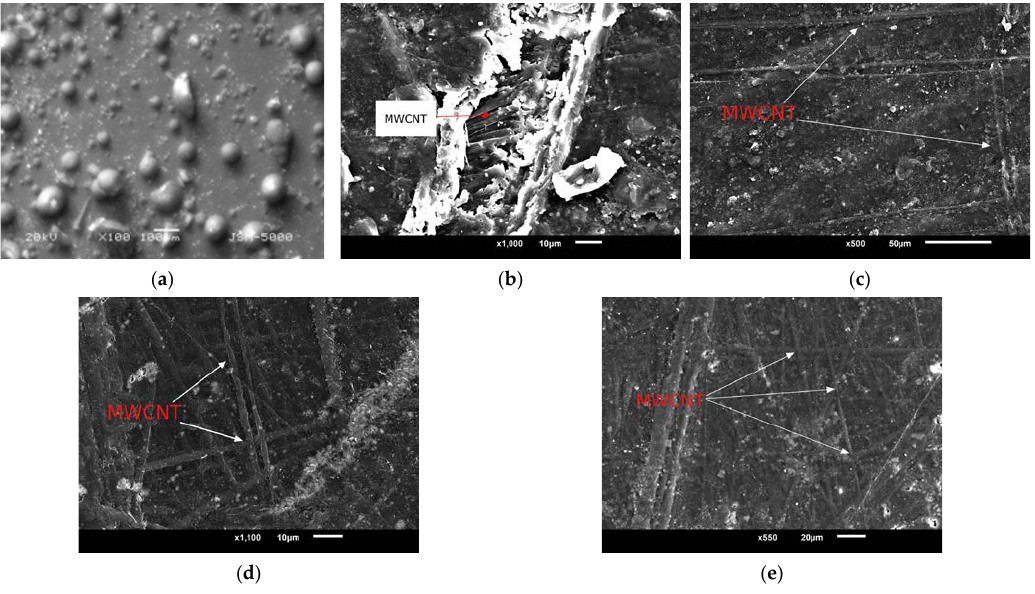
Figure 4. SEM images of ( a ) nanocomposite in powder form, ( b ) crack surface, ( c ) 0.1 wt.% COOH- MWCNT, ( d ) 0.5 wt.% COOH-MWCNT, and ( e ) 1.0 wt.% COOH-MWCNT in PMMA.